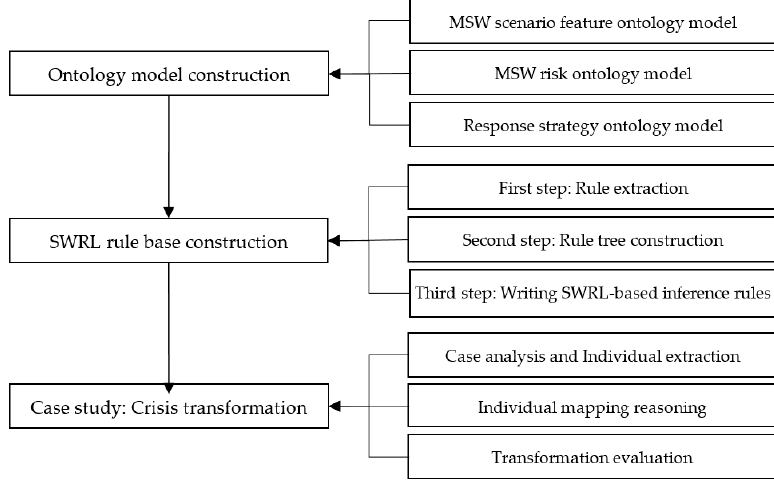
Figure 3. Research framework of MSW risk response based on ontology.